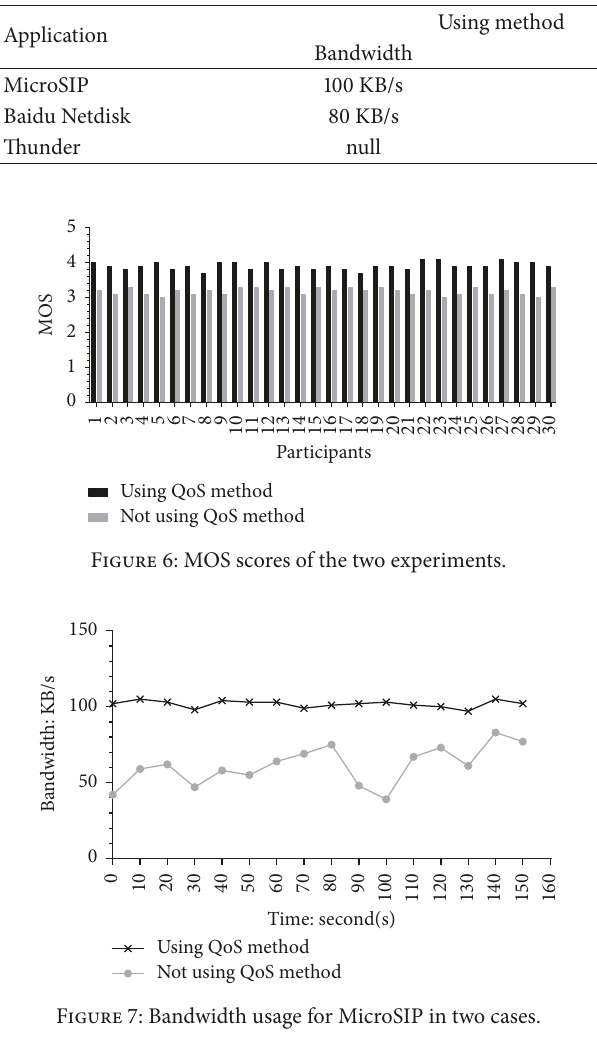
Table 2: Bandwidth and priority configurations in two cases.